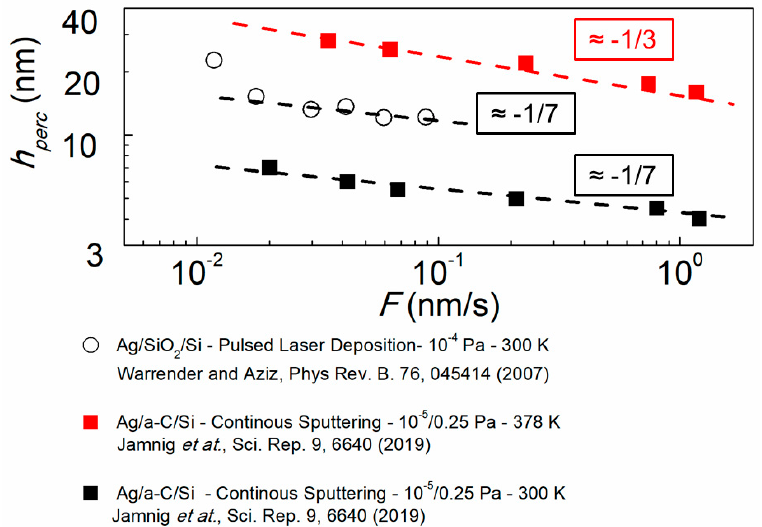
Figure 8. Percolation thickness ℎ (cid:3043)(cid:3032)(cid:3045)(cid:3030) vs. deposition rate 𝐹 (log-log scale) at growth temperatures T = 300 and 378 K, during the growth of Ag on a-C substrates by continuous sputtering (data from [61]), and pulsed laser deposition (data from [111]). The dashed lines are guides to the eye indicating the ℎ (cid:3043)(cid:3032)(cid:3045)(cid:3030) vs. 𝐹 slopes (provided next to each line) for selected set of data. More information on the growth conditions for each data set, including base and working pressure, is provided in the respective